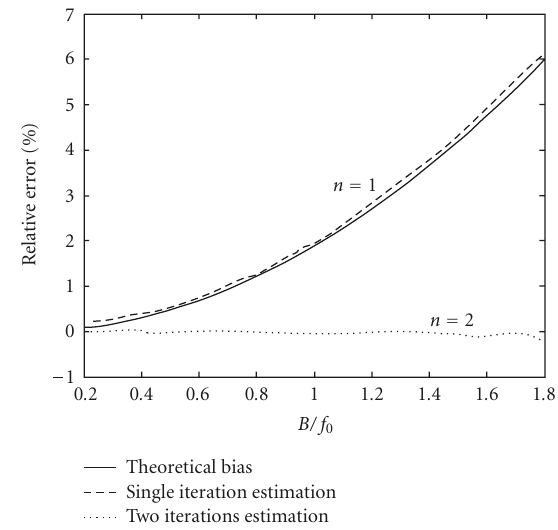
Figure 5: Influence of the bandwidth size. Estimation relative error percentage as a function of the ratio B/ f 0 . Theoretical bias, single iteration estimation, and two iterations estimation are plotted. With only one iteration, a large bandwidth can jeopardize the estimation, but the iterative estimator version can compensate this